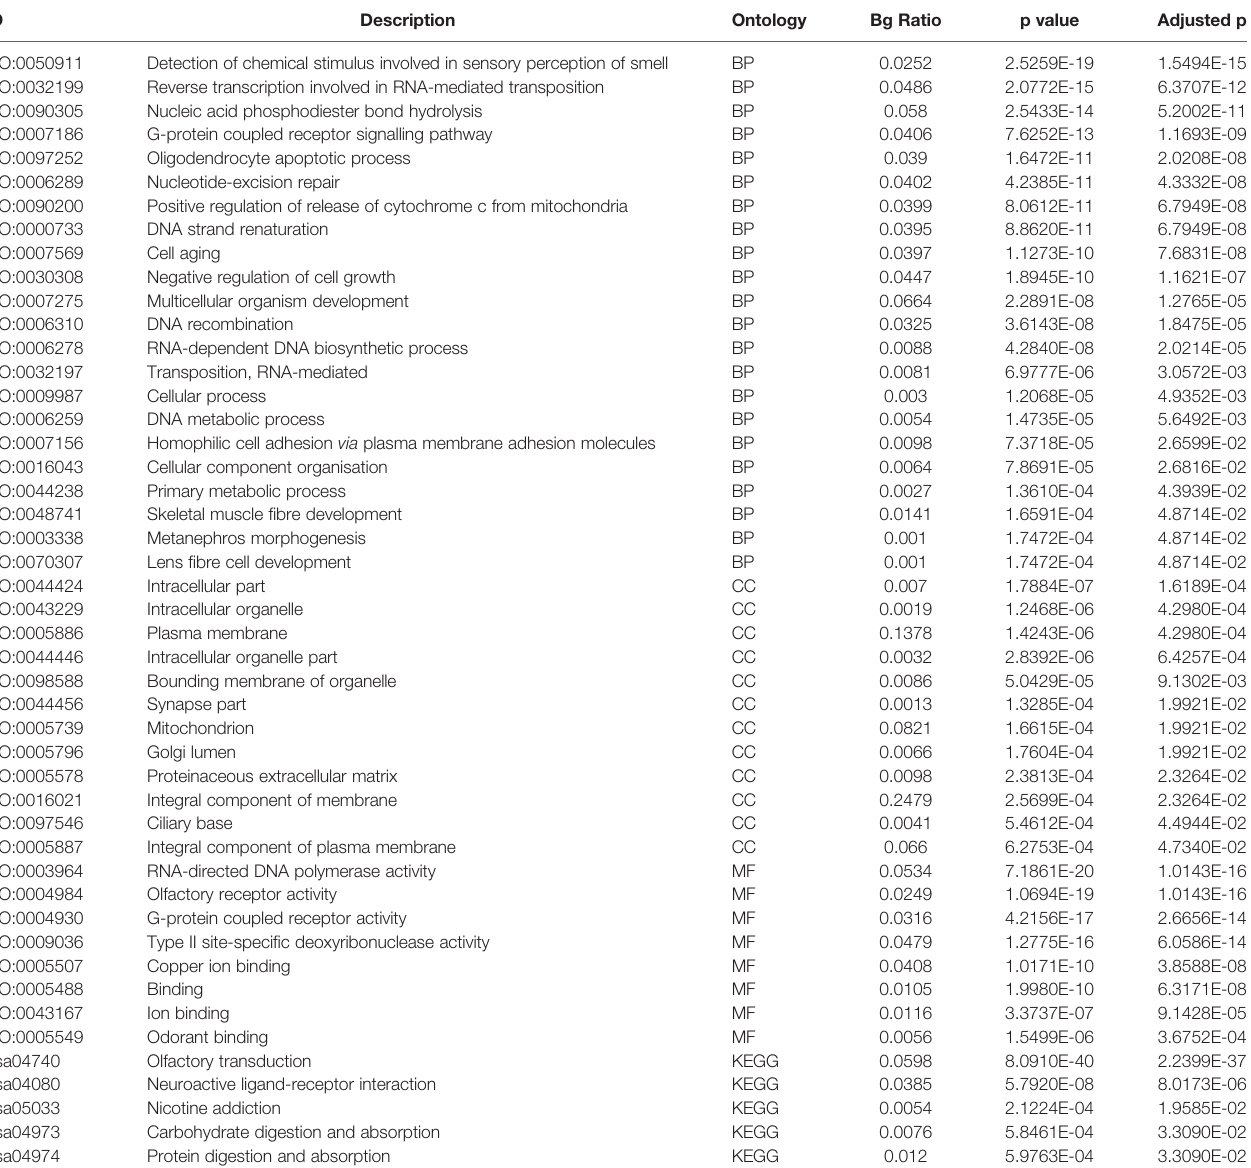
TABLE 4 | Functional enrichment analysis and pathway results of lncRNAs in the ceRNA network.